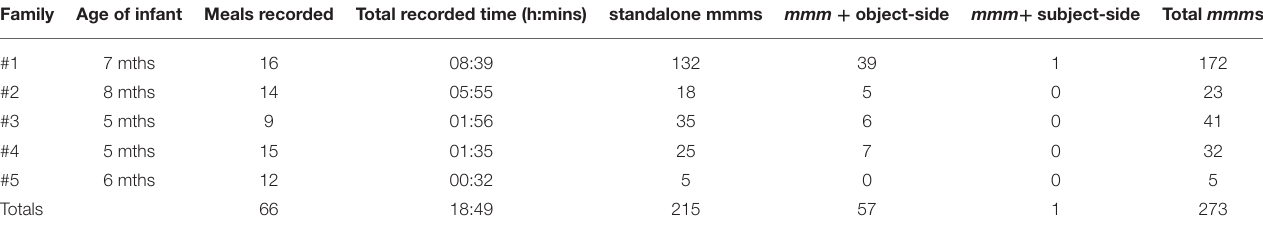
TABLE 1 | Number of gustatory mmms across the data corpus.